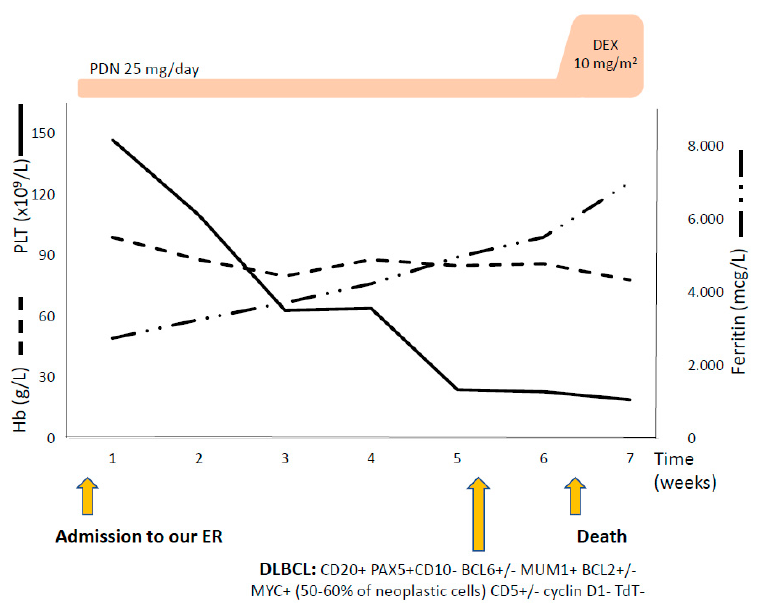
Figure 3. Clinical course of patient #2. Trend of hematologic parameters and therapies administered. Hb: hemoglobin; PLT: platelet count; PDN: prednisone; DEX: dexamethasone; ER: emergency room; DLBCL: diffuse large B cell lymphoma with its